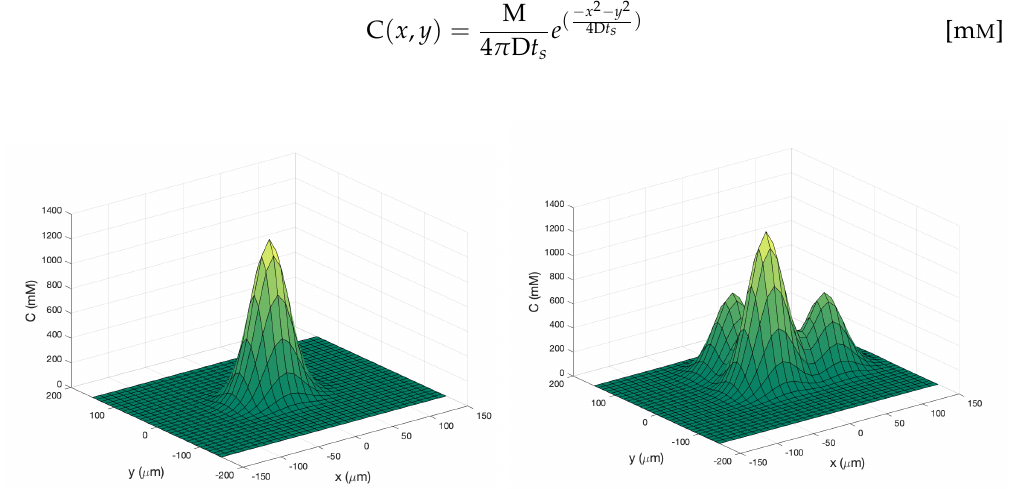
Figure 3. Left : Surface plot of static function (Equation (1)) to describe the single-effluent chemical concentration in the arena. The peak of this one effluent is at the center ( 0,0 ) µm. Right : Surface and contour plots of static composite function to describe the three-effluent chemical concentration imposed on the arena. The highest peak is located at the center ( 0,0 ) µm while the two local peaks are at ( 0,80 ) µm and ( 80,0 )